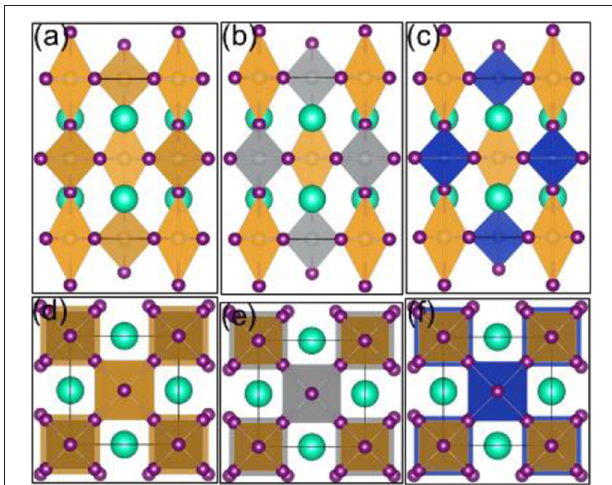
FIGURE 1 | 1B-based perovskite solar cell absorber crystal structures: (a) Cs 2 Au(I)Au(III)I 6 , (b) Cs 2 Ag(I)Au(III)I 6 , (c) Cs 2 Cu(I)Au(III)I 6 : side view; (d) Cs 2 Au(I)Au(III)I 6 , (e) Cs 2 Ag(I)Au(III)I 6 , (f) Cs 2 Cu(I)Au(III)I 6 : top view. Yellow, gray, and blue shapes represent Au, Ag, and Cu atoms, respectively. Visualization was performed with VESTA (Momma and Izumi,